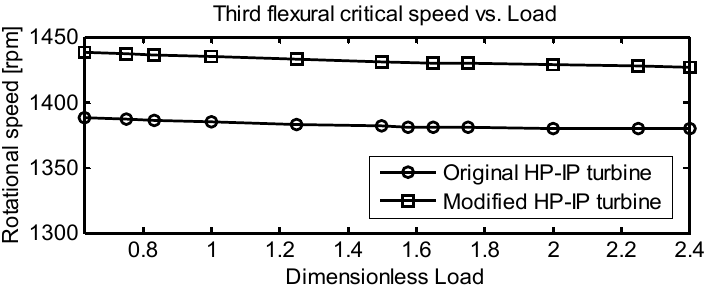
Fig. 23. Third fl exural critical speed plotted vs. the dimensior less load, after fl exural stiffness cbanges of the HP-IP truhine.